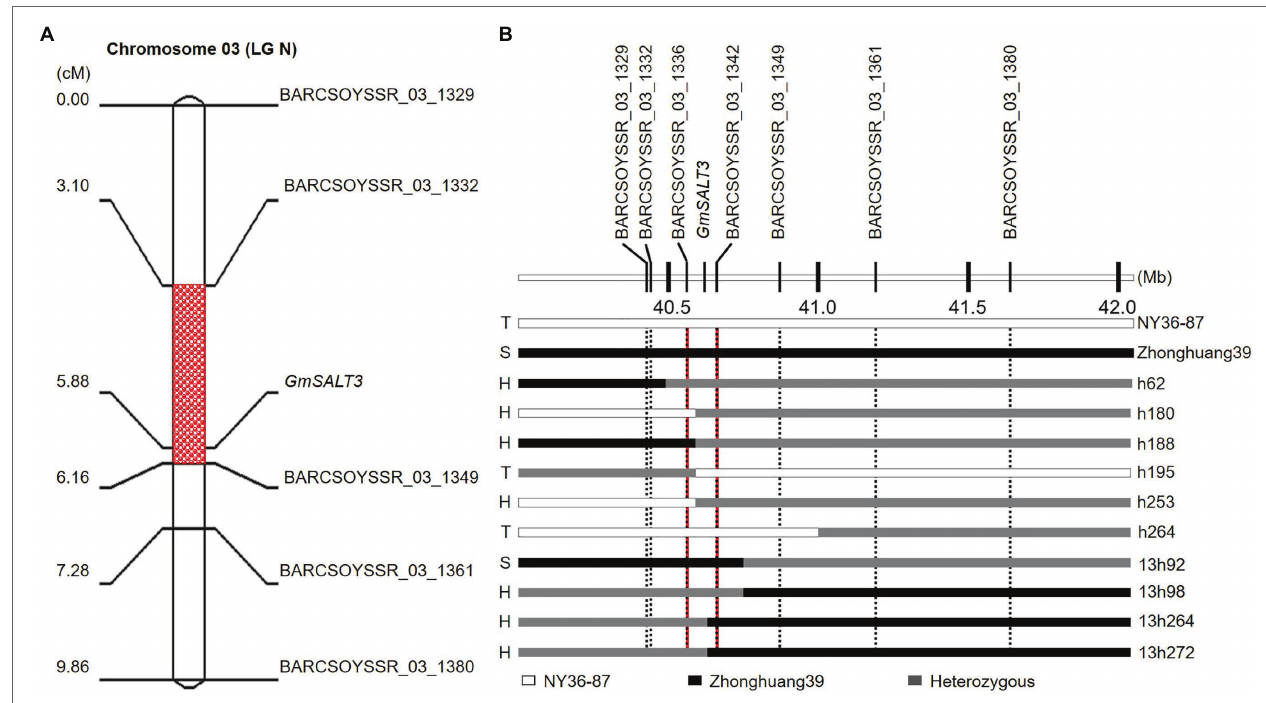
FIGURE 2 | Mapping the salt tolerance locus in the Zhonghuang39 × NY36-87 population. (A) Salt tolerance-related locus mapped on soybean Chr. 03. (B) Fine mapping of the salt-tolerance gene. Individuals are shown to the right and phenotype to the left of the graphic. T, S, and H indicate tolerant, sensitive, and heterozygous (segregating) phenotype,